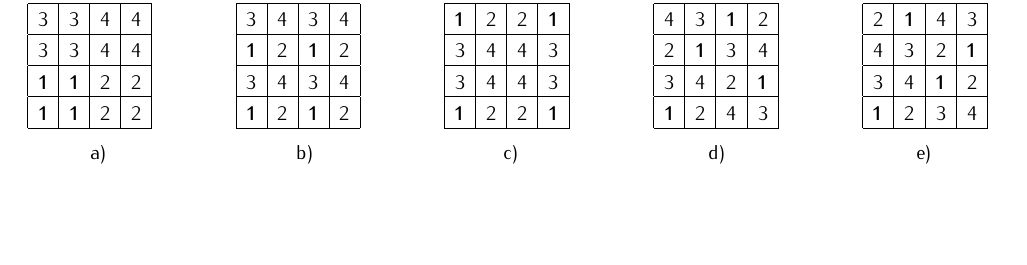
4 . The generating subgroups are denoted by bold 1 . The supersquares